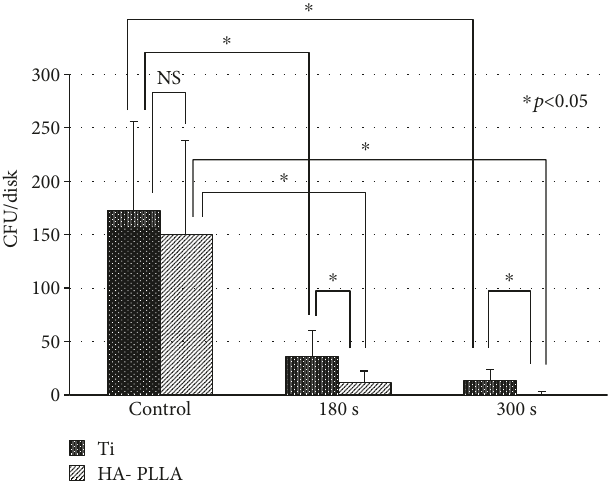
Figure 6: E ff ect of irradiation with a 405 nm blue-violet laser on the growth of bacteria adhered to the surface of Ti and HA-PLLA. Irradiation with the 405 nm blue-violet laser for 180 s and 300s signi fi cantly inhibited the bacterial growth. Values are mean ± SD from 20 samples per group. ∗ p < 0 05